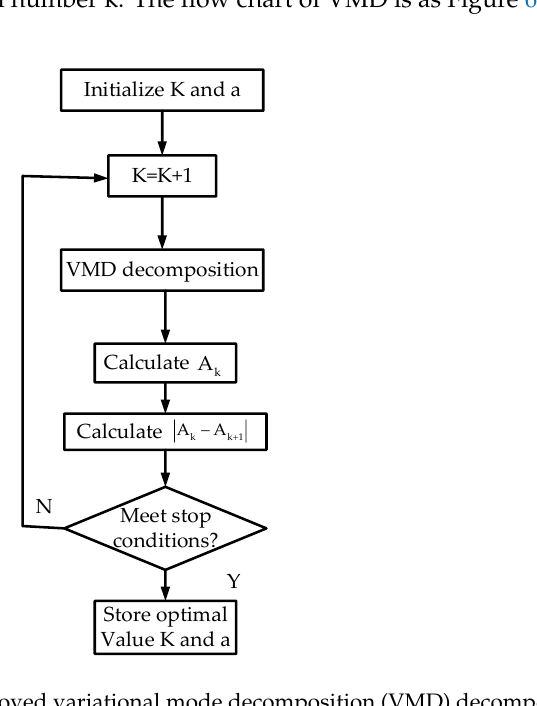
Figure 6. The flow chart of improved variational mode decomposition (VMD) decomposition.